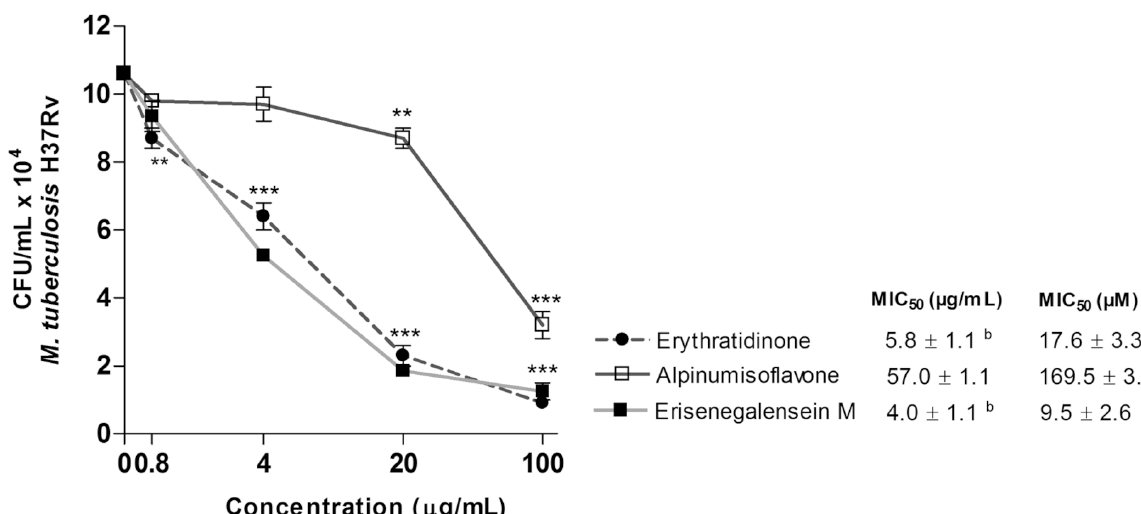
Figure 4. Effect of isolated substances and most active fractions from Erythrina verna on M. tuberculosis growth in macrophages. RAW 264.7 macrophages were infected with M. tuberculosis strain H37Rv at the infection ratio of 1:1(macrophage:mycobacteria) and treated with samples for 4 days . Bacterial intracellular viability after the treatment was determined by bacterial CFU counts. Statistical analyses were calculated and compared to untreated group ( *** p < 0.001, ** p < 0.01 and * p < 0.05). Minimum inhibitory concentrations of samples on M. tuberculosis growth in macrophages were calculated and values in the same column with different superscript letters (a-c) are significantly different ( p < 0.05 or p < 0.001; determined by Tukey test). Values are reported as m ean value ± SD (n =